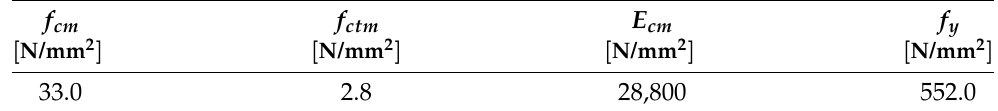
Table 1. Material properties of the concrete and reinforcement,